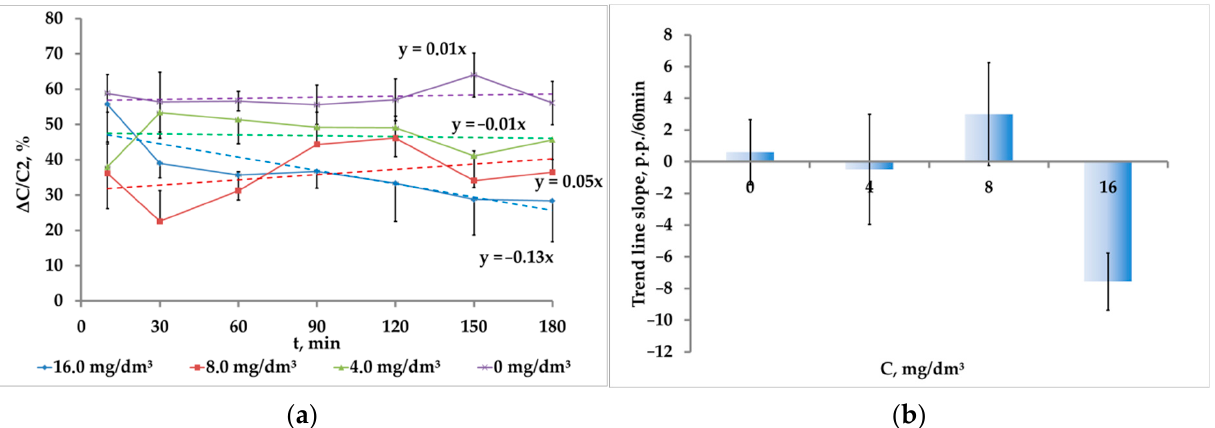
Figure 5. Approximation of ∆ C/C 2 dynamics and ( a ) the slope of fitting lines ( b ) under the influence of various concentrations of K 2 Cr 2 O 7 on A. salina .